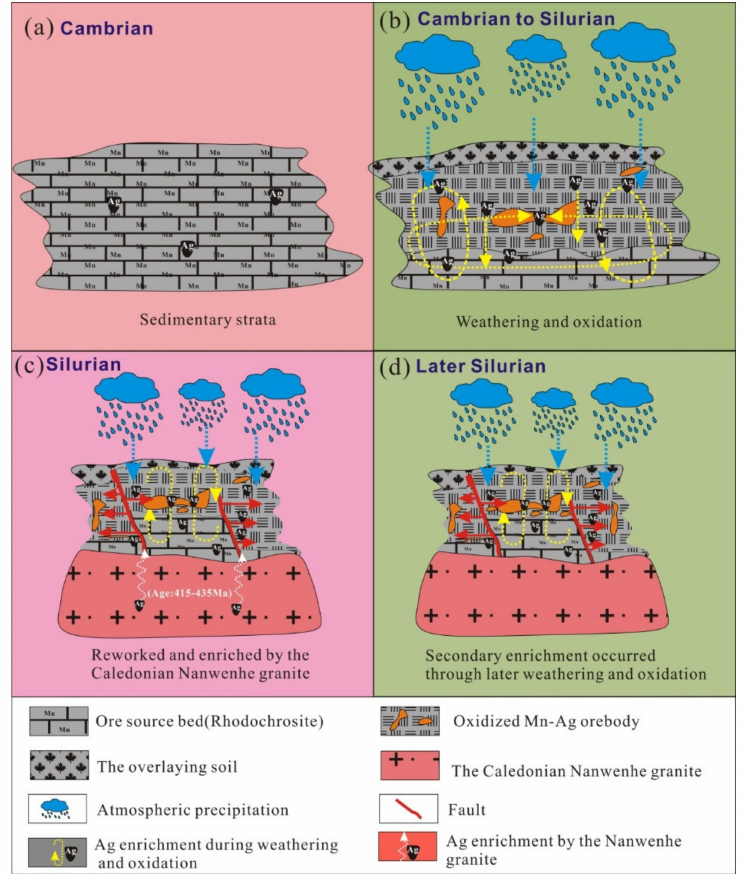
Figure 15. Genesis model of the Sanbao deposit: ( a ) Cambrian: sedimentation stage and ore source-bed started to form; ( b ) Cambrian to Silurian: weathering and oxidation (supergene) of ore body; ( c )